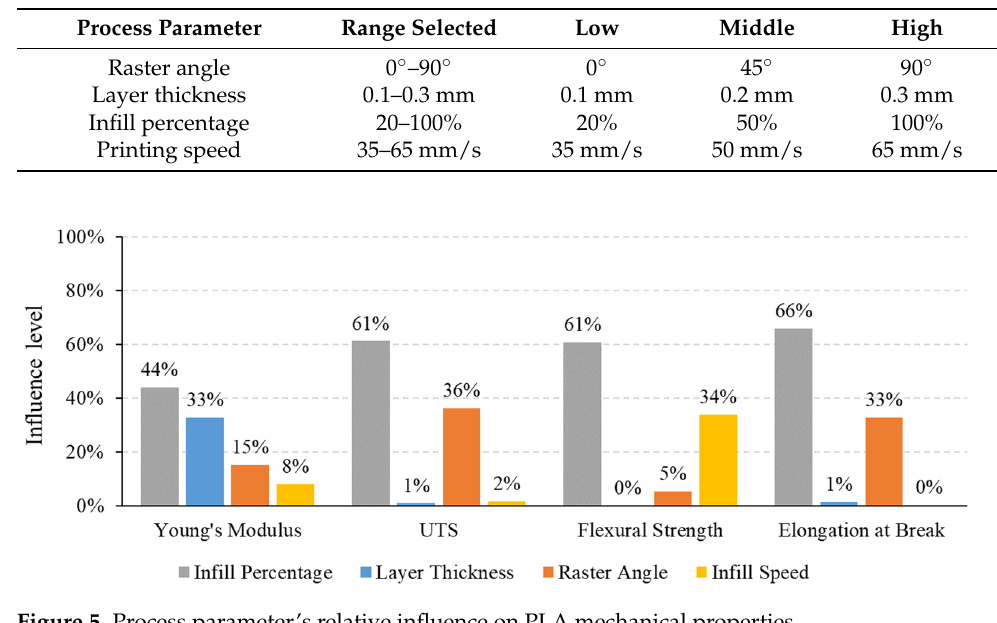
Table 2. Process parameters range used for PLA along with the related settings.